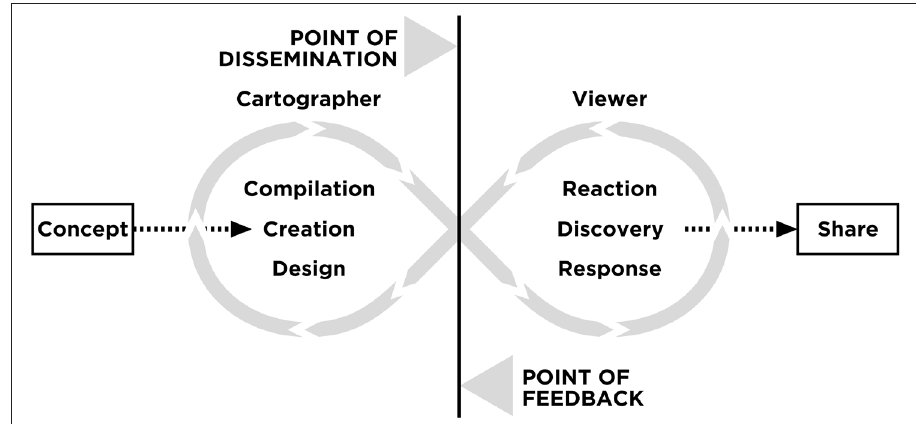
Figure 2: A new map communication